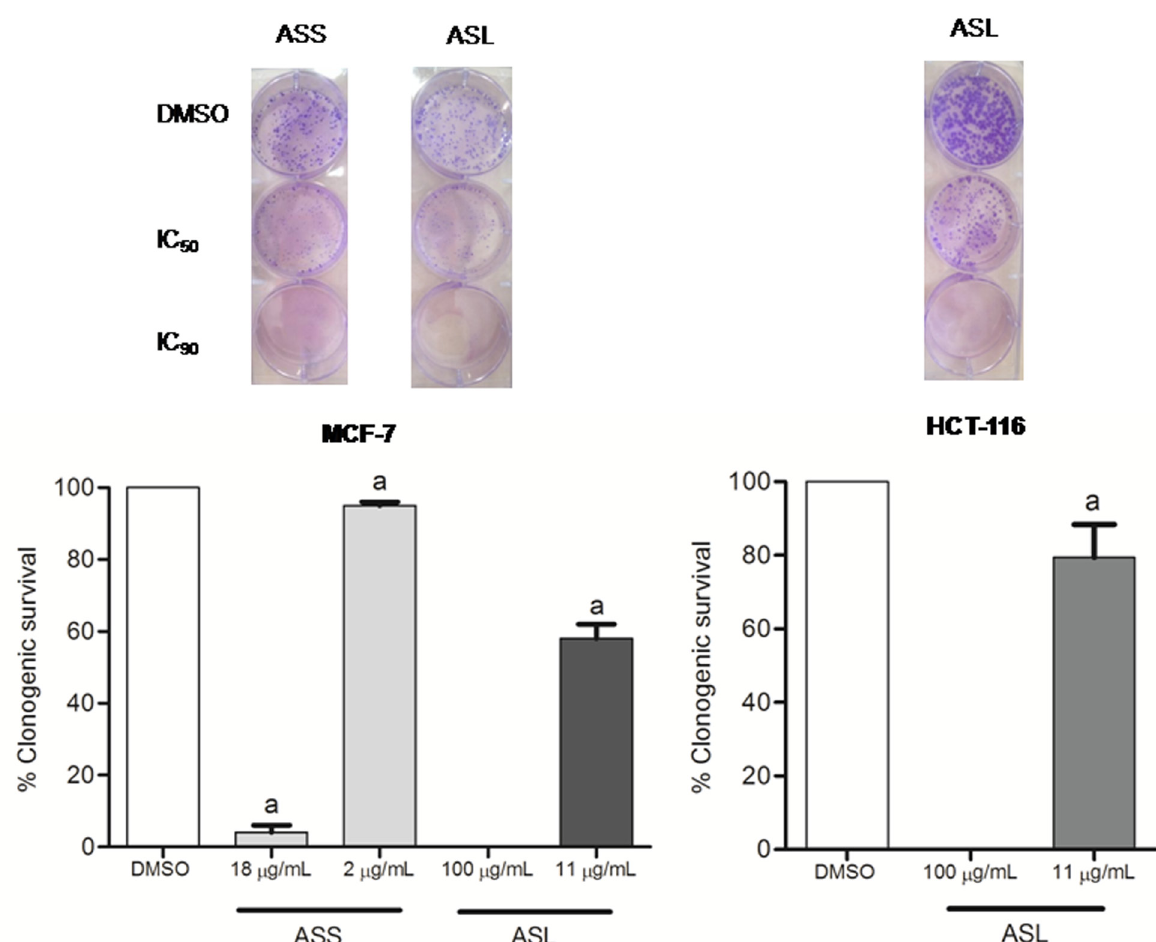
Figure 9 - Effects of methanolic extracts of Annona squamosa seeds (ASS) and leaves (ASL) on clonogenic survival of MCF-7 and HCT-116 cells. The lineages were seed at density of 4x10 3 cell/well and treated with the extracts at their IC or control (0.5% DMSO) for 24 hours. Medium was replaced by fresh complete medium and cultured for 14 days. The fraction of survival was determinate. Representative data of three independent experiments performed in duplicate. a Statistically different from negative control (0.5% DMSO) (ANOVA followed by Bonferroni, P <